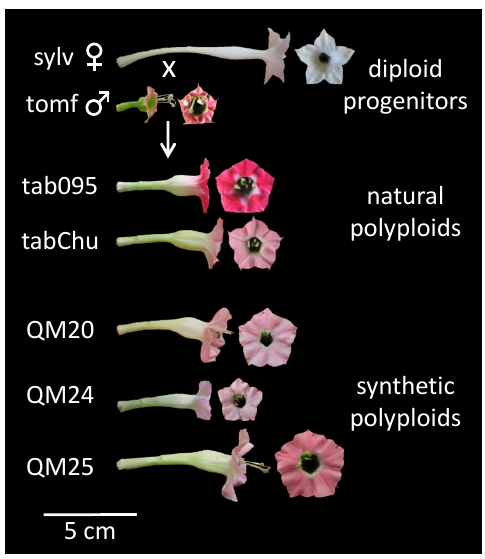
Figure 1. Floral morphology of diploid progenitors N. sylvestris and N. tomentosiformis , two natural N. tabacum accessions (095-55 and ‘Chulumani’), and three synthetic N. tabacum lines (QM20, QM24, and QM25): all accessions pictured here are included in the cell size data set, whereas all accessions except QM20 were used in the transcriptome analyses. Sylv = N. sylvestris , tomf = N. tomentosiformis , tab095 = N. tabacum 095-55, tabChu = N. tabacum ‘Chulumani’, QM20 = synthetic N. tabacum QM20, QM24 = synthetic N. tabacum QM24, and QM25 = synthetic N. tabacum